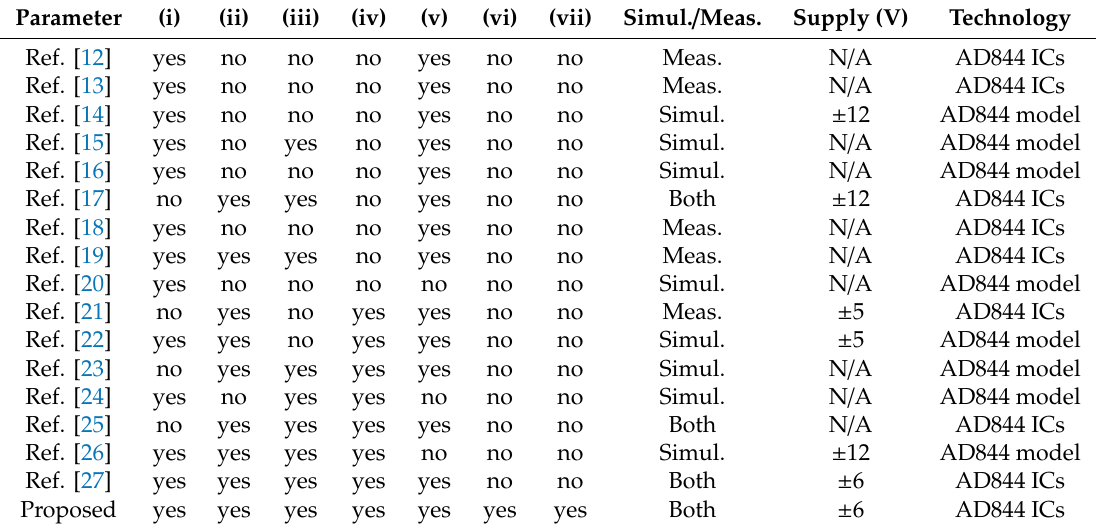
Table 1. Comparison of the previous reported CFOA-based VM biquad